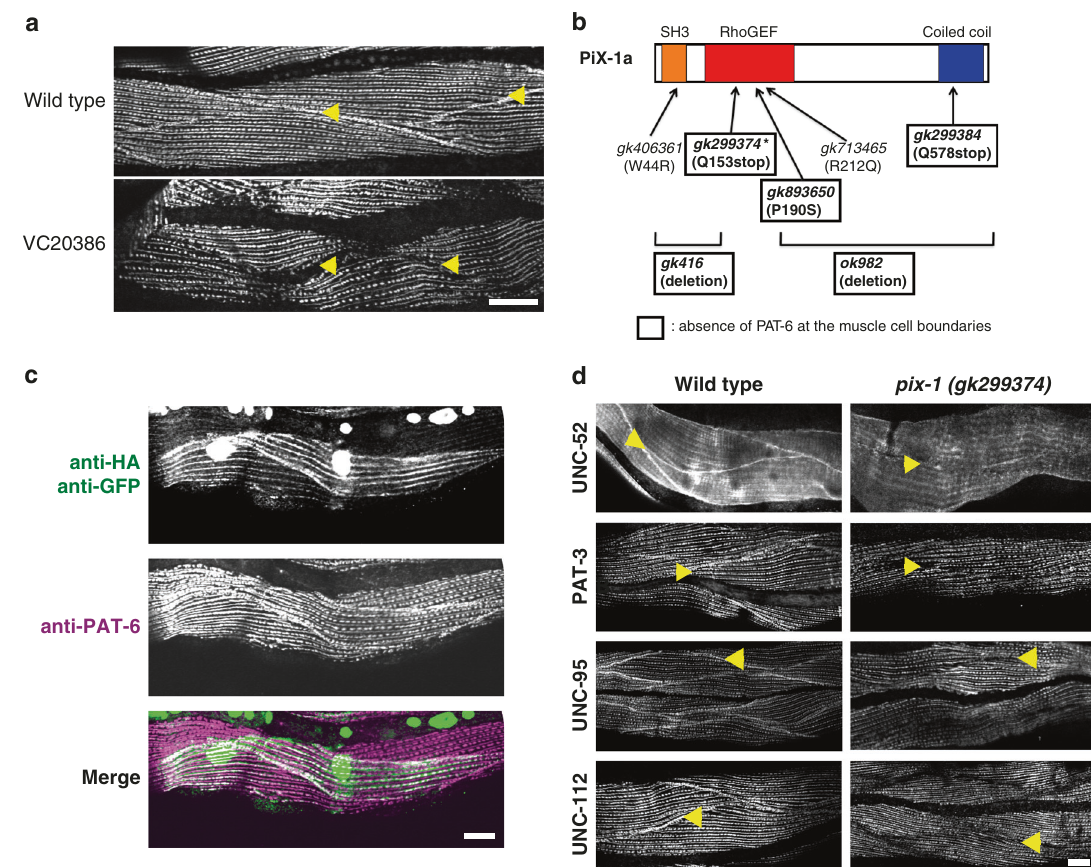
Fig. 1 Identi fi cation of pix-1 as a gene required for the assembly of IACs at muscle cell boundaries. a Confocal images of several body wall muscle cells immunostained with antibodies to PAT-6 ( α -parvin) from wild type and the strain VC20366 identi fi ed by screening 574 MMP strains. Arrowheads point to the boundaries between muscle cells. b Schematic representation of domains in C. elegans PIX-1a, and the location and nature of 7 pix-1 mutants and evaluation of their phenotypes. The asterisk denotes the pix-1 mutant allele found in the original strain VC20366. c Muscle-speci fi c expression of a wild- type cDNA for PIX-1 tagged with HA rescues the phenotype of pix-1(gk299374) . The transgene is sfEx61 [myo-3p::HA-PIX-1; sur-5::nls::GFP], in which sur-5:: nls::GFP is the transformation marker showing GFP in nuclei. Note that PAT-6 has been restored to the muscle cell boundaries (indicated by arrowheads), and that HA-tagged PIX-1 localizes to muscle cell boundaries, dense bodies, and M-lines. d Comparison of wild type vs. pix-1(gk299374) immunostained with antibodies to the indicated IAC proteins and imaged by confocal microscopy. Arrowheads denote muscle cell boundaries. Note that all four proteins are present in wild type but missing from muscle cell boundaries in the pix-1 mutant. Each image is a representative image obtained from at least 2 fi xation and immunostaining experiments, and imaging at least three different animals. Scale bars in ( a ), ( c) and ( d ), 10 μ